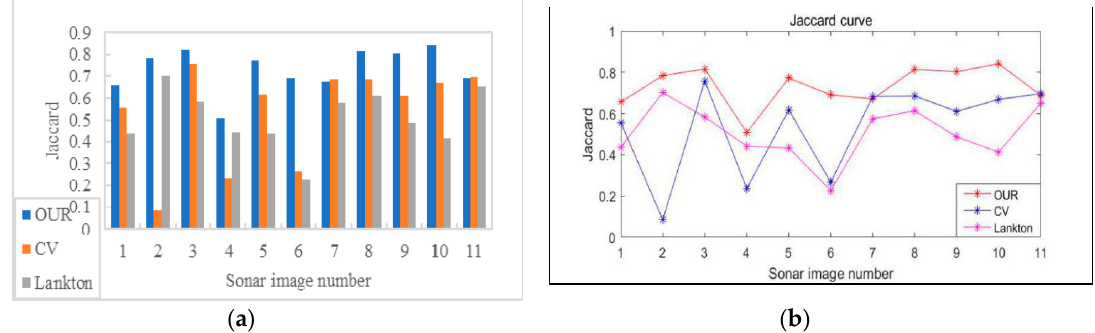
Figure 12. Dice curve. ( a ) Histogram of Dice. ( b ) Line chart of Dice.